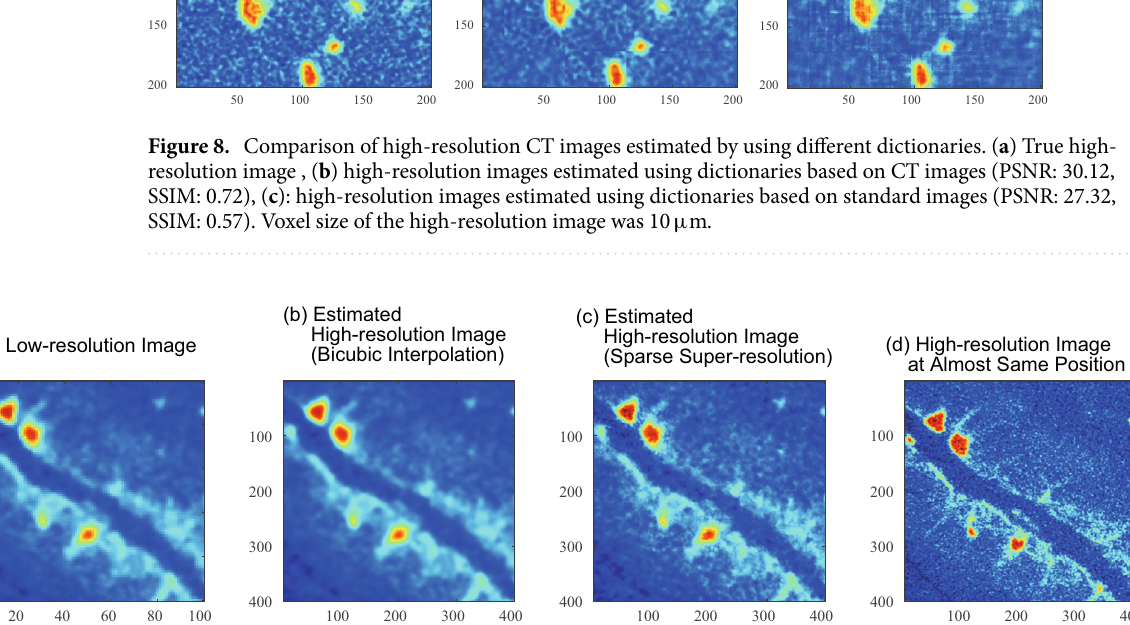
Figure 9. Application of the proposed method to directly obtained low-resolution image. ( a ) Low-resolution image directly obtained by X-ray CT scanner. ( b ) Estimated high-resolution image by bicubic interpolation. ( c ) Estimated high-resolution image by sparse super-resolution. ( d ) High-resolution image recorded at almost same position by X-ray CT scanner. Voxel size of the high-resolution image was 10 µ m